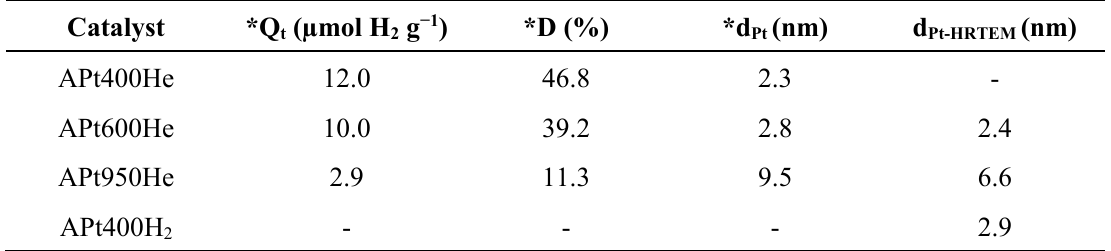
Table 4. Hydrogen uptake (Q t ), dispersion (D) and Pt particle size of supported catalysts.